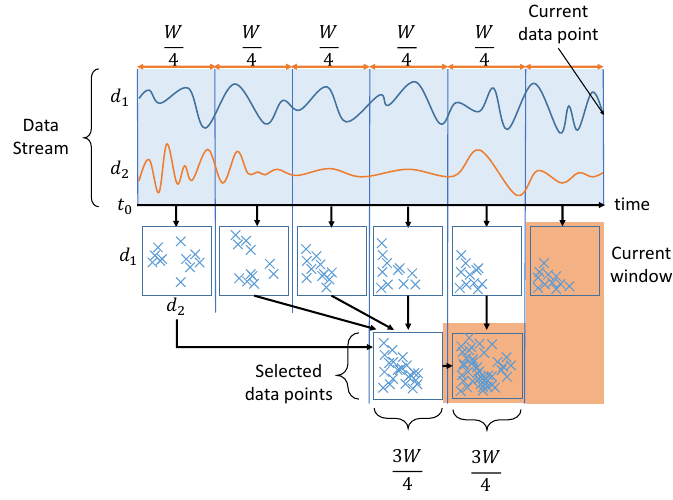
Figure 1. The summarization phase of